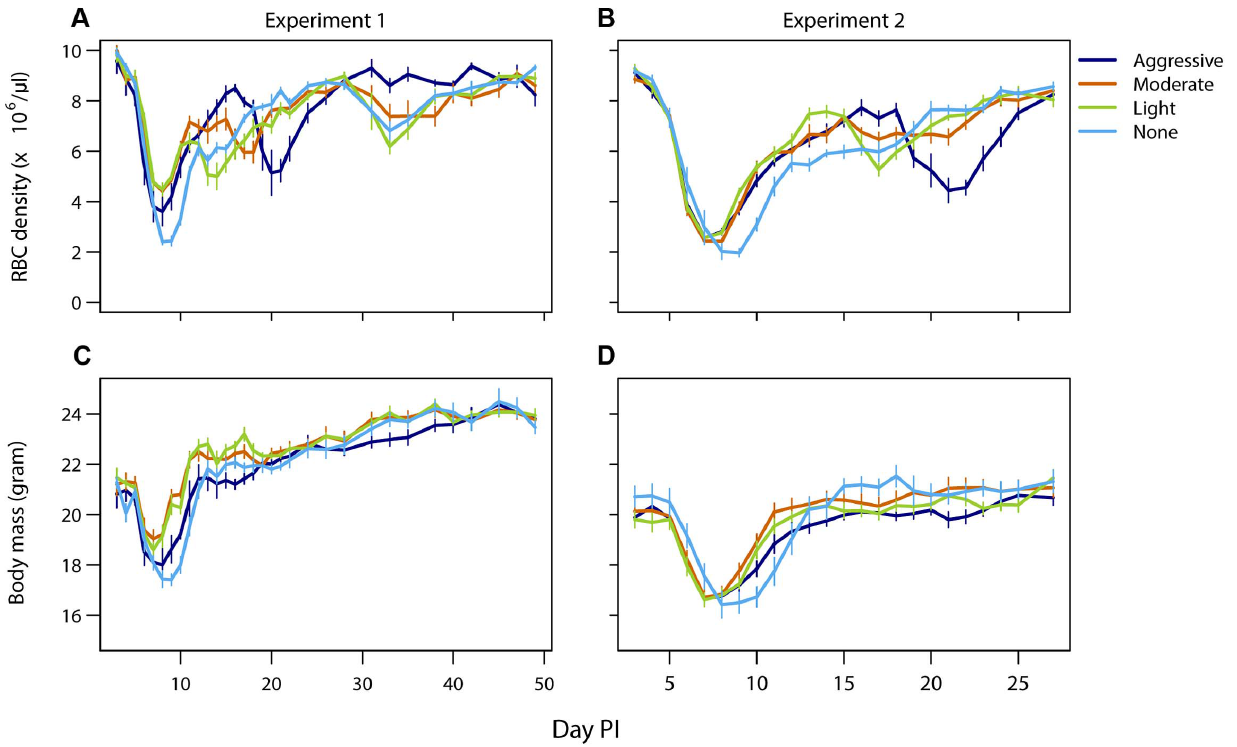
Figure 4. Light touch regimens improve host health as much or better than aggressive chemotherapy. Mean red blood cell (A,B) and body mass (C,D) dynamics of mice in experiment 1 (left panels) and experiment 2 (right panels) that were treated (day 6 PI) with an aggressive (dark blue), moderate (orange) or a light (green) drug dose or left untreated (light blue). Data are means ( 6 s.e.m.) with sample sizes as in Table 1.